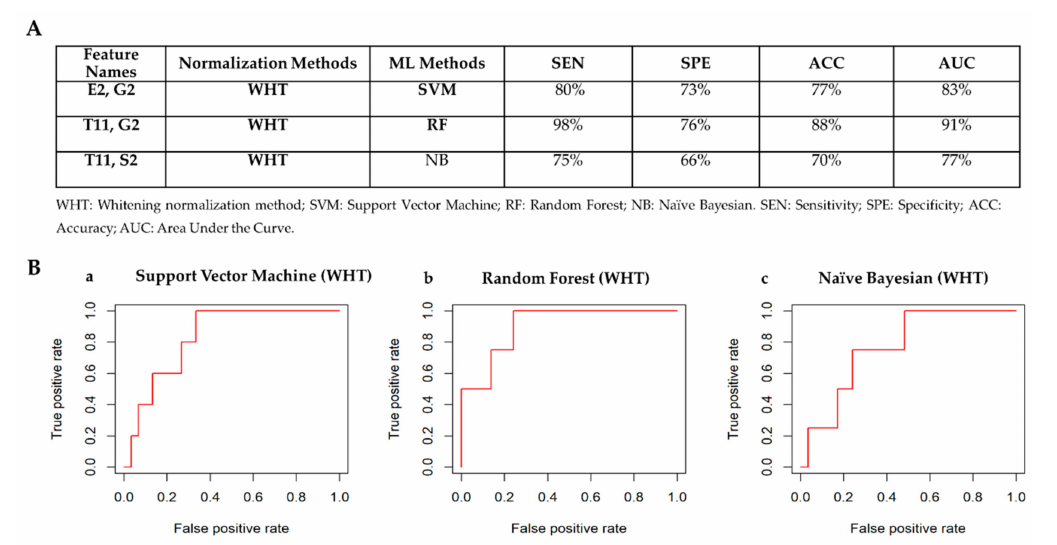
Figure 11. Classifiers’ performance to detect TN receptor status. ( A ) Comparison table among classifiers: TN vs Others. ( B ) ROC curves for the best classifiers to automatically detect TN receptor status. a) Best classifier for Support Vector Machine Method. The normalization methods that achieved the best performance is the quantile normalization method. b) Best classifier for Random Forest Method. The normalization method that achieved the best performance is the quantile method. c) Best classifier for Naïve Bayesian Method. The normalization method that achieved the best performance is quantile